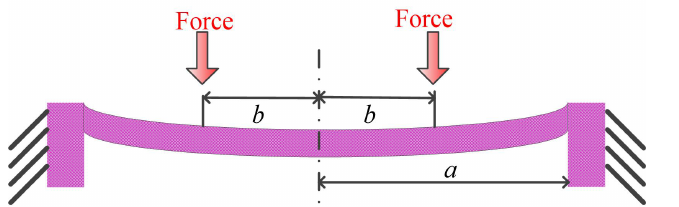
Figure 3. Circular clamped-edge plate concentrically loaded, a is the radius and b is the annular position. Closed form analytical solutions for annular membrane Equations (4) and (5) from Timoshenko [49] were used to calculate the membrane deflection due to the load on